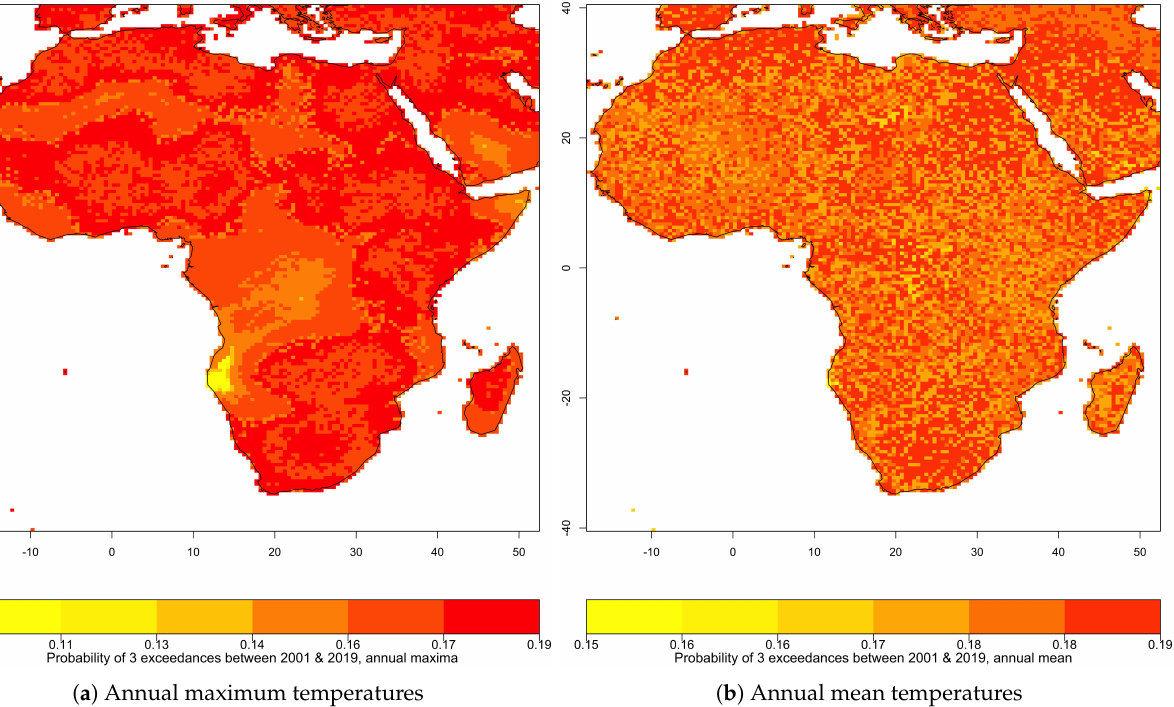
Figure 5. Map of probability of 3 ( k = 3) exceedances, over the period of 2001 to 2019 ( n = 19), of extremes in ( a ) annual maximum temperatures and ( b ) annual mean